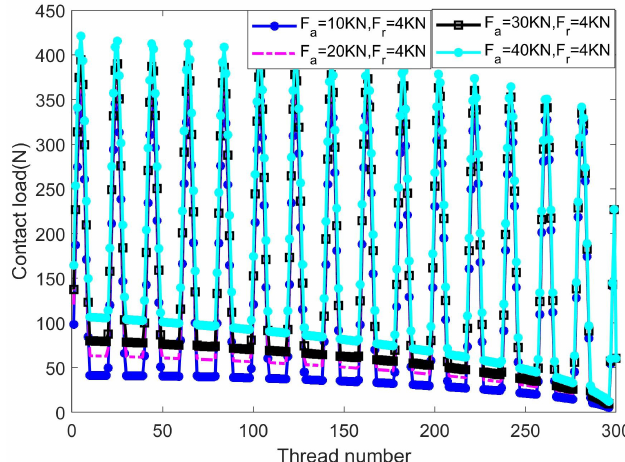
Figure 16. The effects of different axial loads in case 1.